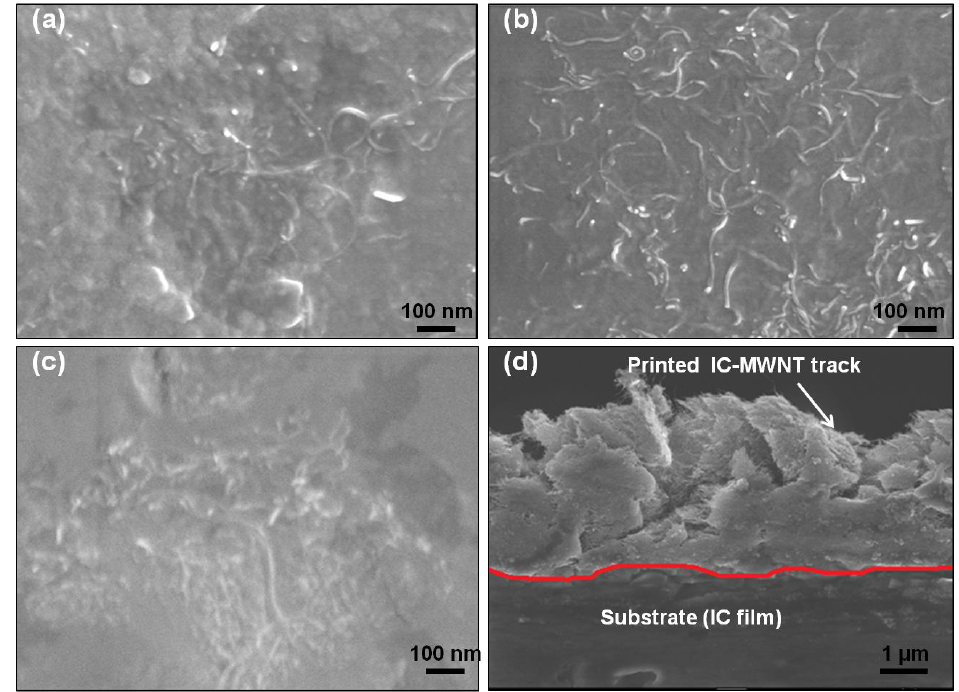
Figure 9. SEM images of IC-MWNT extruded patterns onto ( a ) glass; ( b ) PET sheet and ( c ) IC film substrates; ( d ) Cross-sectional view of IC-MWNT tracks printed onto IC film substrate. The red line indicates interface between track and the substrate.